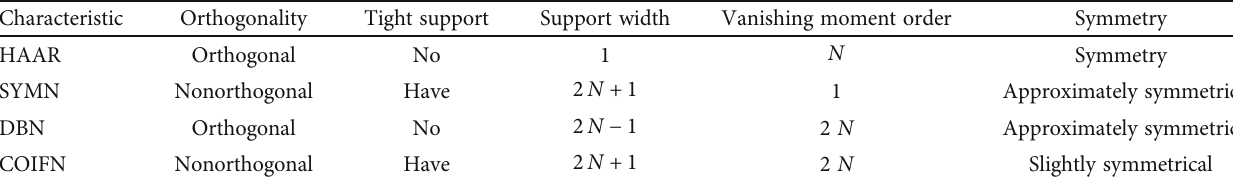
Figure 1: Wavelet analysis algorithm fl ow. Table 1: Wavelet basis function